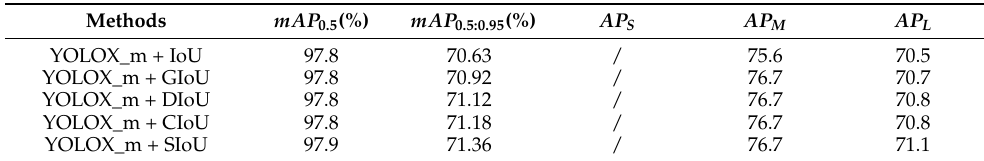
Table 5. Performance comparison of different regression loss functions.